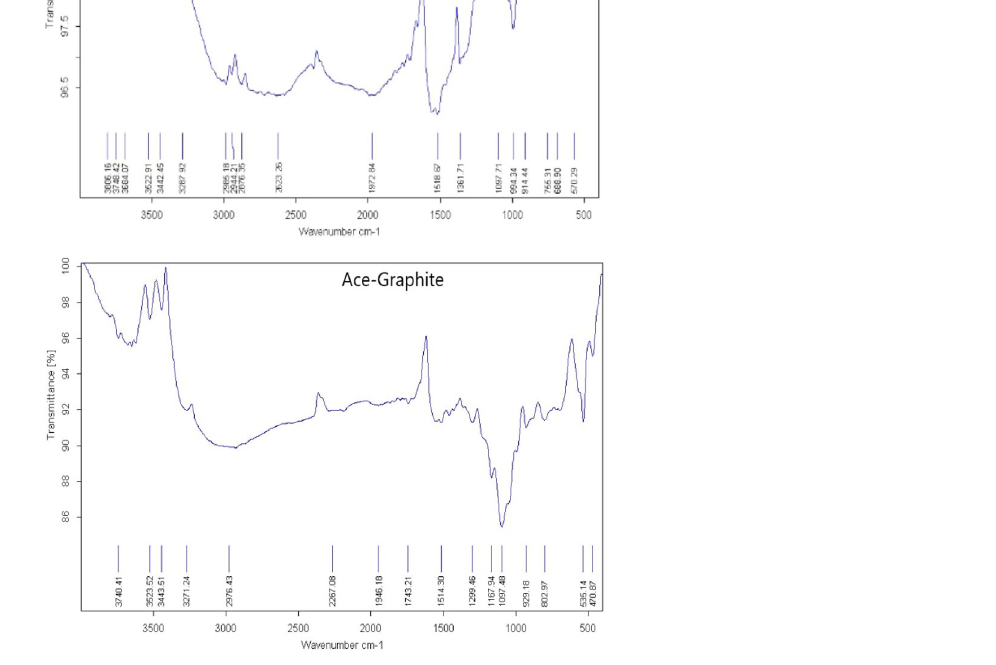
Figure 5. IR Spectrum of